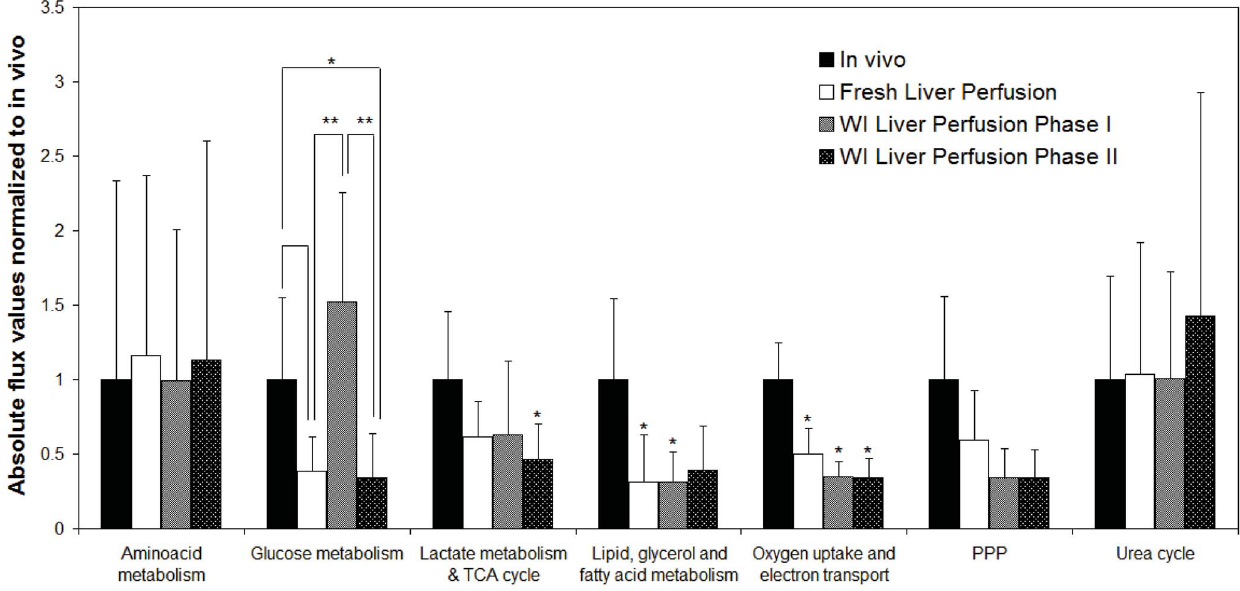
Figure 6. Summary of major pathways in perfused livers normalized to invivo values.